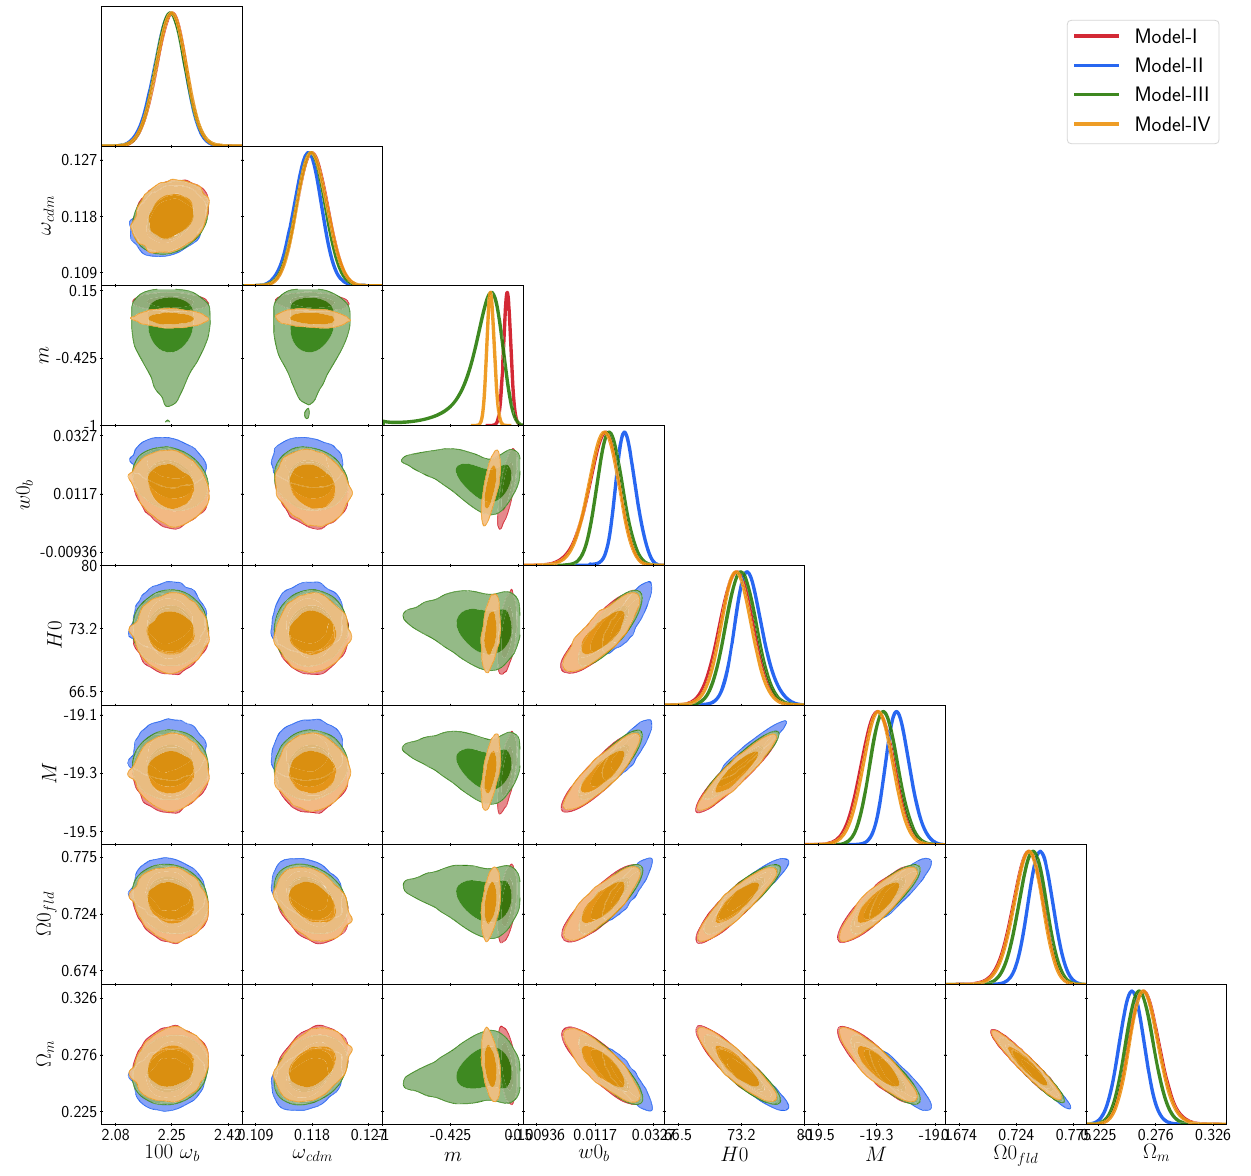
Fig. 2 Posterior distribution for the cosmological parameters of the four models using data set II (Pantheon +BAO + HST) and PLANCK18 prior has been considered